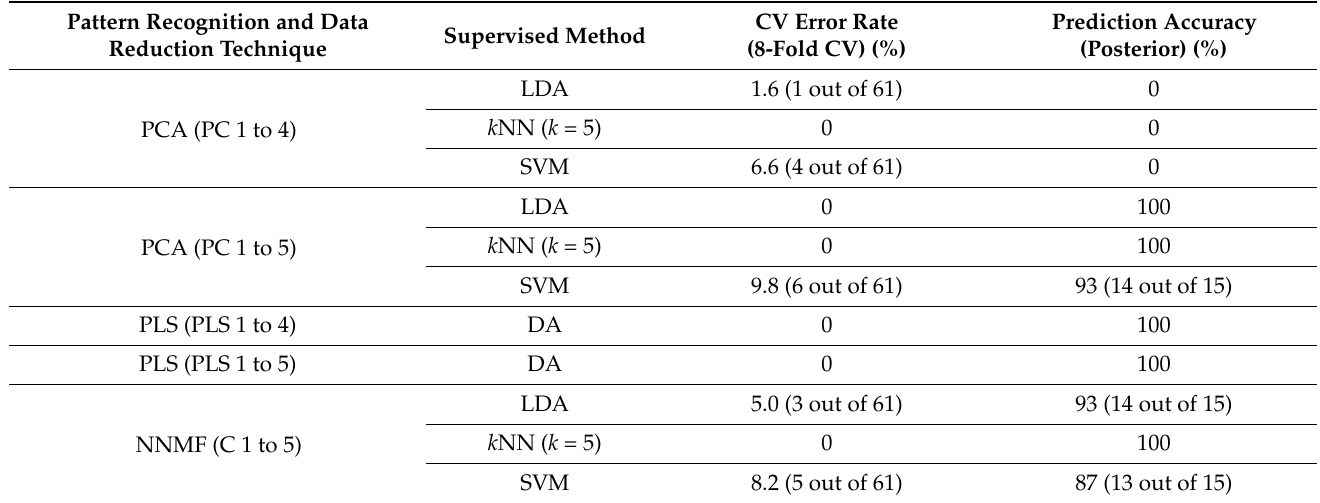
Table 2. Prediction results for 5 labels. (L)DA = (linear) discriminant analysis; k NN, k -nearest neighbor classification, k = number of neighbors; SVM = support vector